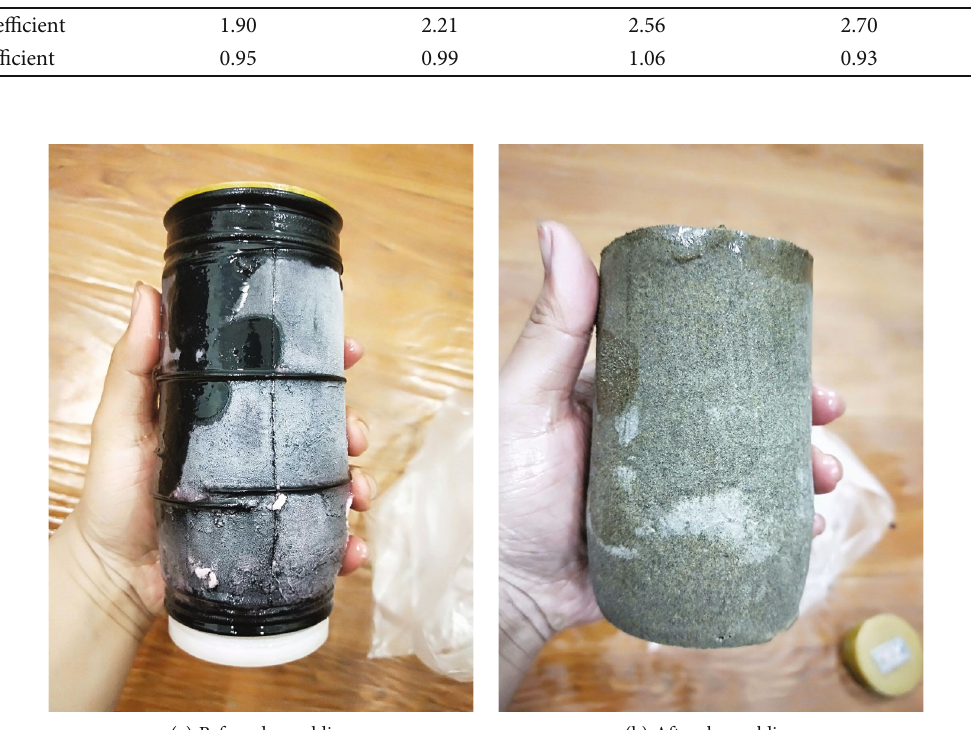
Figure 3: Shear failure mode of soil